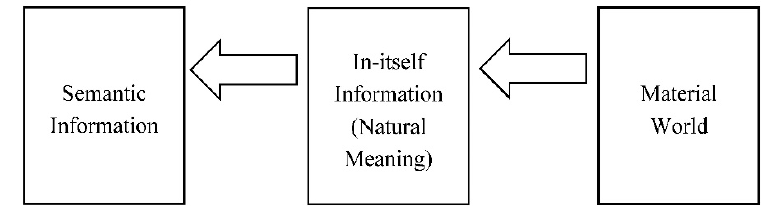
Figure 2. Wu’s Aristotelian PI. According to Wu, the natural world does not equal to material world. The natural world actually includes the material world and the informational world. Furthermore, the informational world is derived from the material world, so it can reflect the material world to some extent. Moreover, the informational world can be divided in to subjective and objective information worlds. The objective information is not meaningless data. It has a Gricean natural meaning. The semantics evolve from such a natural meaning. Therefore, the relationship between information and matter in Wu’s PI is just like the Aristotelian relationship between form and matter, even though Wu does not refer to form in terms of